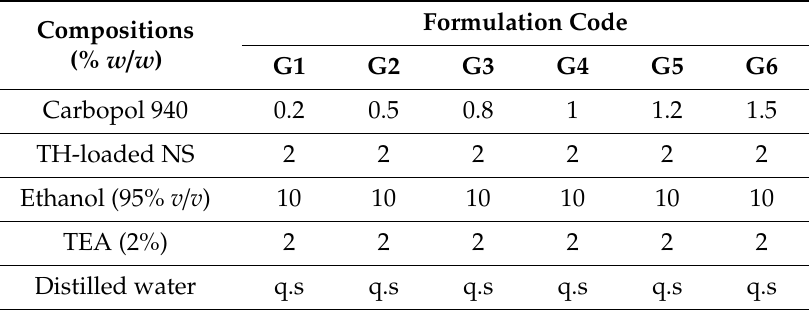
Table 4. Composition amount of HG